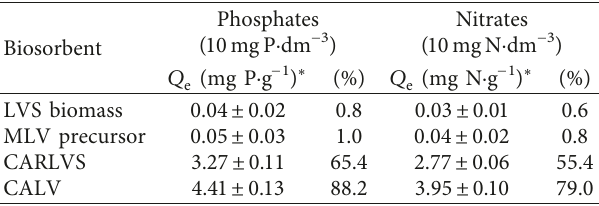
Table 3: Biosorption efficiency of phosphate and nitrate by cationic biosorbents based on raw (LVS) and alkaline-modified (MLV) bottle gourd